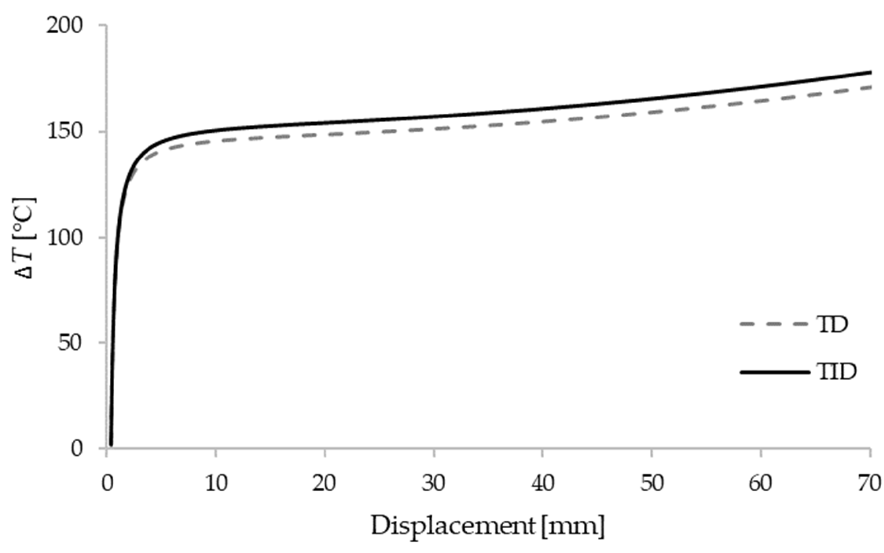
Figure 5. Critical temperatures vs. displacement for a clamped–clamped beam L 1 = 6 m with λ = 0.5 .